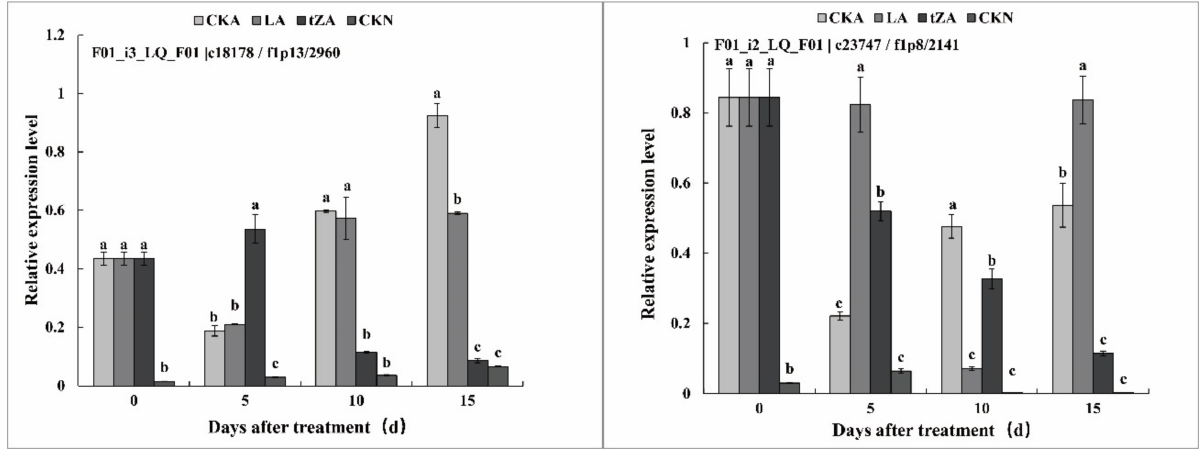
Figure 6. The relative expression level of trans-zeatin related genes in CKN, CKA, tZA and LA groups after the treatment. Different lower-case letters among different treatment groups indicate significant differences based on one-way analysis of variance in SPSS 21.0 followed by the Duncan’s test ( p <